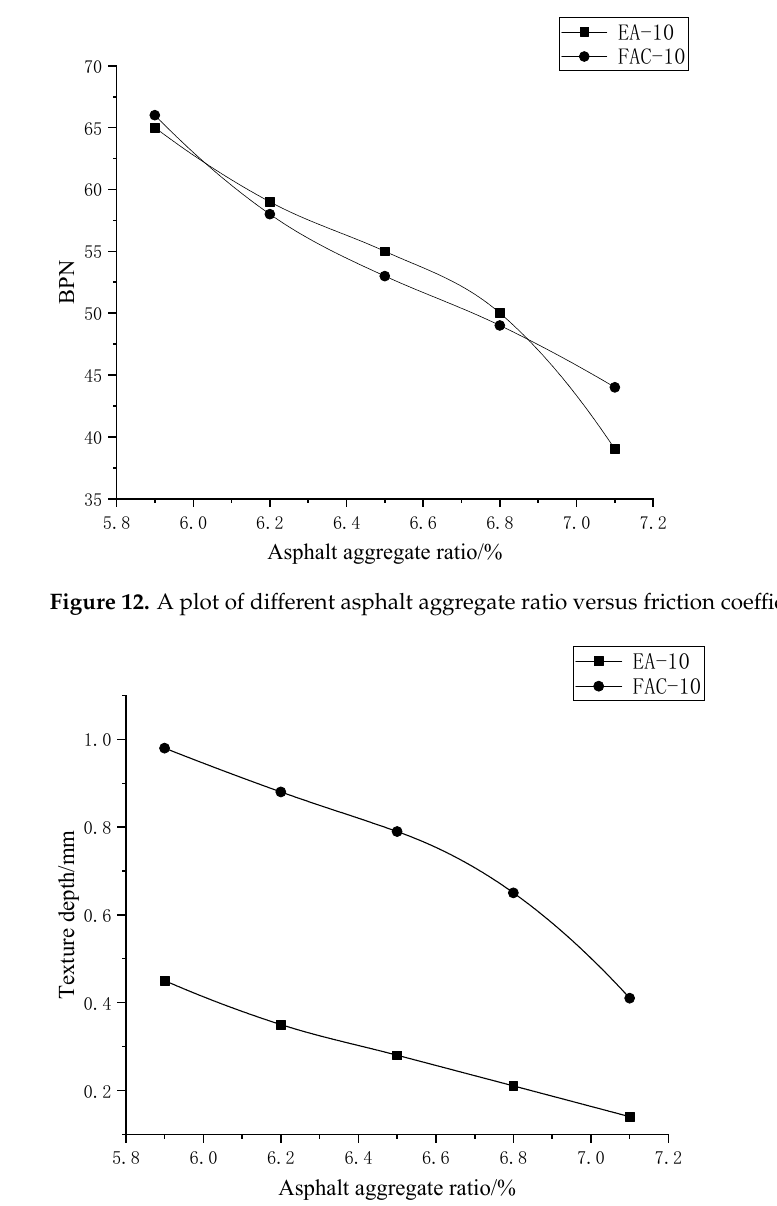
Figure 13. A plot of different asphalt aggregate ratio versus tectonic depth.